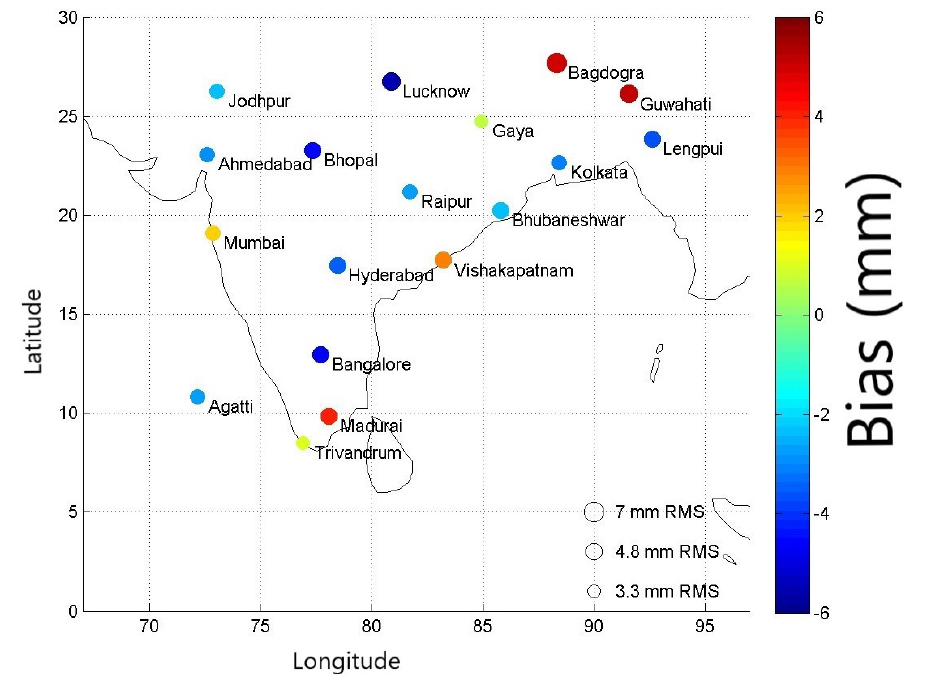
Figure 2. Bubble plot depicting station-wise comparison between GPS-derived IWV and IWV from ERA-I after bias correction of surface pressure. (The colors depict the bias in mm for each station, and the size of the bubbles depict the